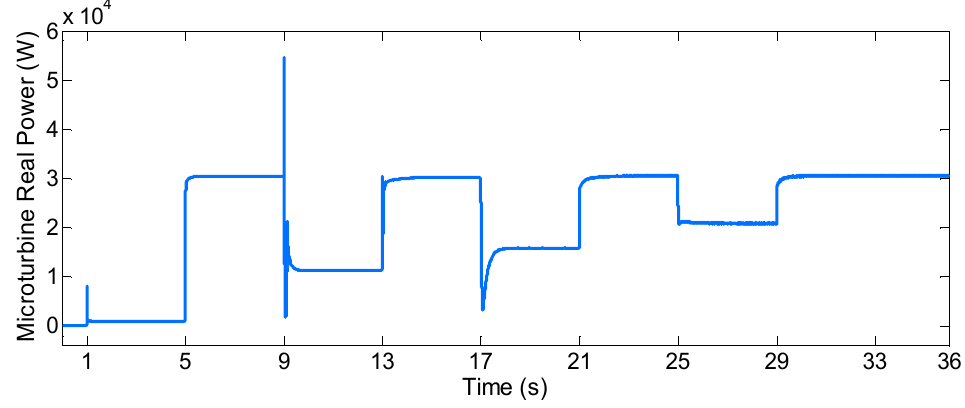
Figure 13. Microturbine real power during the restoration process.